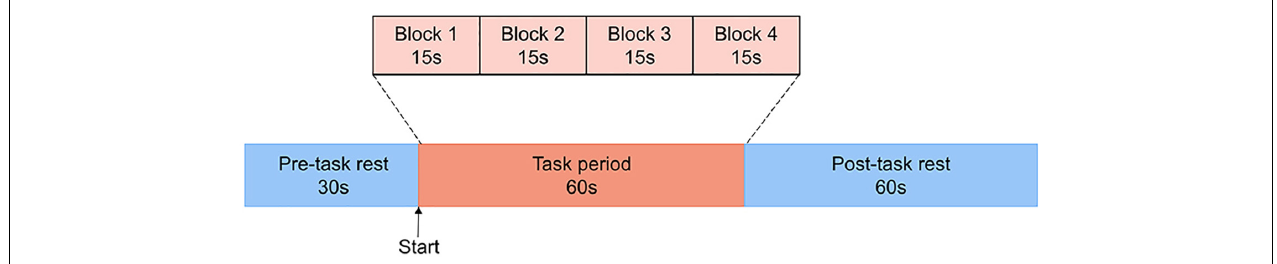
FIGURE 1 | The VFT protocol used for near-infrared spectroscopy. Each trial consisted of a 30s pre-task rest period, a 60s task period subdivided into four 15s blocks and finally, a 60s post-task rest